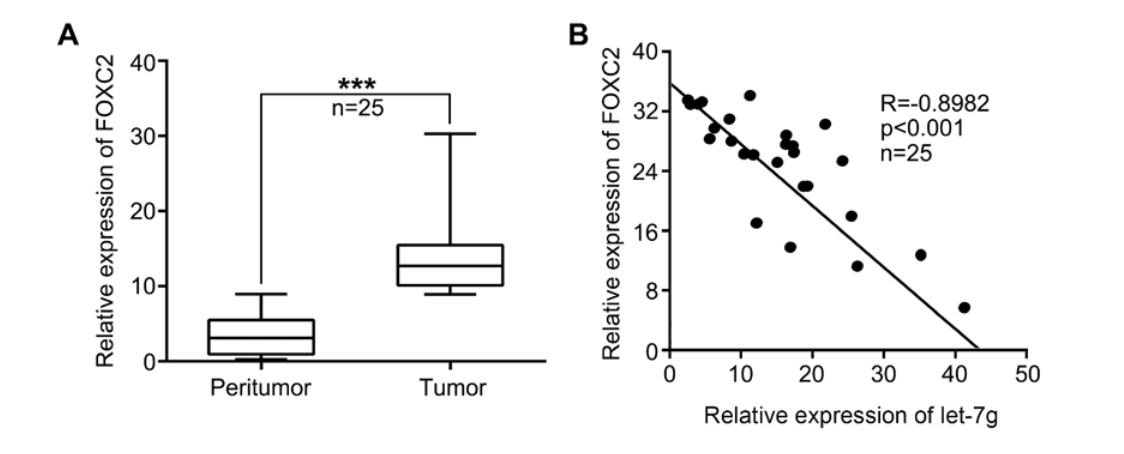
Figure 1: Let-7g negatively correlates with FOXC2 in human breast cancer samples with bone metastasis. (A) FOXC2 expression was tested by qRT-PCR in 25 breast tumor tissues with bone metastasis and peritumor tissues. (B) The association of let-7g with FOXC2 was analyzed by qRT-PCR in 25 breast cancer tissues with bone metastasis (Pearson’s correlation coefficient, r=-0.8982). (Statistical differences: *** P < 0.001; Student’s t test)